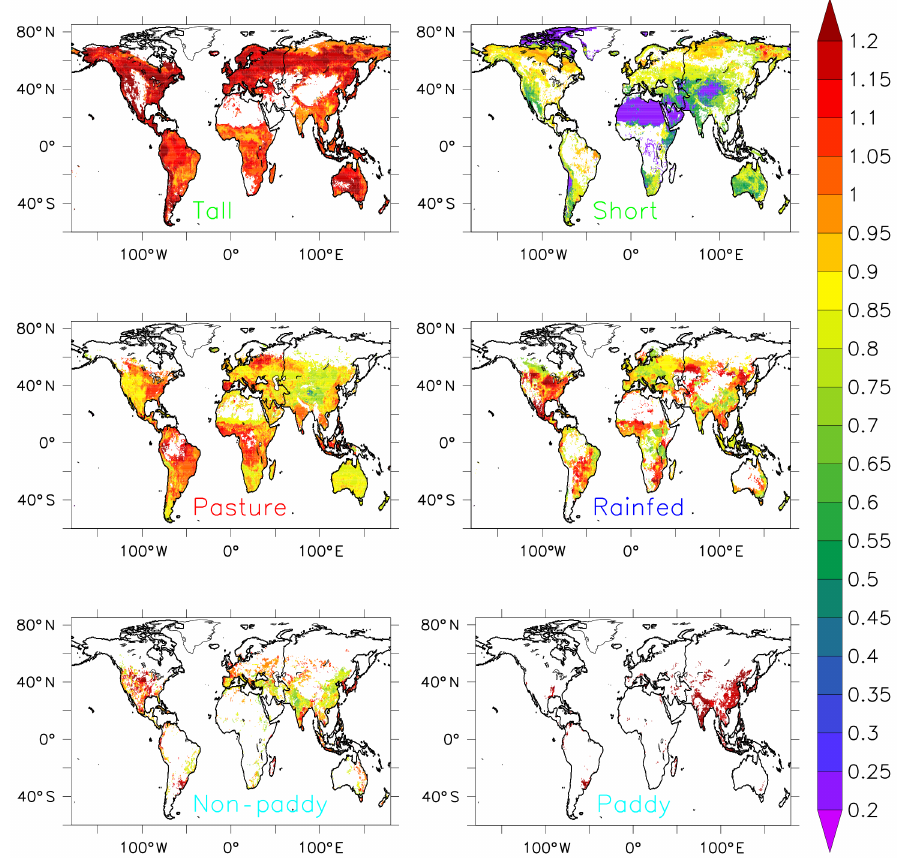
Figure A2. Maximum crop factors ( k c ) in LC2000 per land cover type, used to compute land-cover-specific potential evapotranspiration (ET pot = k c · ET refpot ). For each grid cell the maximum value is given, which may occur at different times during the year. Values are given where a land cover type covers more than 1% of a grid cell. Black lines indicate the masks used for the continents in Fig. A1. Note that short natural vegetation includes desert areas where the crop factor is set to a minimum value of 0.2, hence the low crop factors for short natural vegetation in, for example, Africa (see Fig. A1). Low crop factors for short natural vegetation in North Africa derive from Arctic